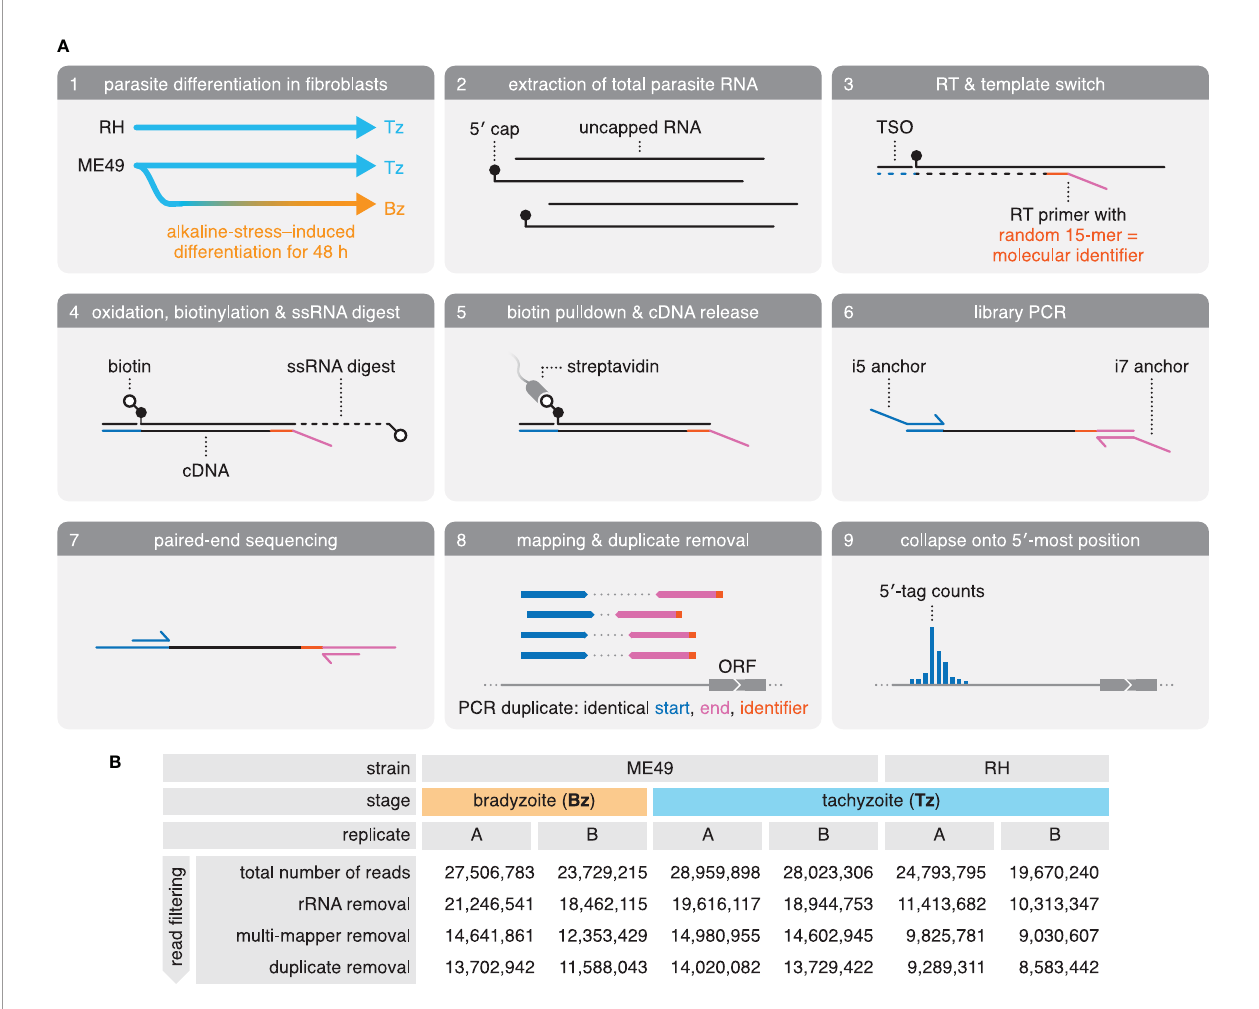
FIGURE 1 | Generation and sequencing of 5 ′ -intact cDNA libraries from total RNA extracts of multiple Toxoplasma strains and life-cycle stages. (A) Preparation and sequencing of 5 ′ -intact cDNA (RAMPAGE) libraries. Total RNA was extracted from RH and ME49 Tz, as well as ME49 Bz that were differentiated by culture in alkaline-pH medium. Sequencing adapters were introduced during reverse transcription (RT). Here, an RT primer anneals randomly to RNA transcripts, introducing the Read 2 sequencing adapter (magenta), and a template-switching oligo (TSO) introduces the Read 1 sequencing adapter (blue) at the 5 ′ end of the RNA transcript. 5 ′ -intact cDNA was enriched via a cap-trapping strategy, in which riboses with free 2 ′ - and 3 ′ -hydroxyl groups are oxidized and biotinylated, and single- stranded portions of RNA (ssRNA) are digested by RNase I. This retains biotin only at the cap-structure of 5 ′ -intact RNA transcripts, which was used in a streptavidin pulldown to enrich for the 5 ′ -intact cDNA within the RNA-cDNA heteroduplex. Libraries were ampli fi ed by PCR, introducing the i5 and i7 anchor sequences for Illumina fl ow cells. Following size selection, libraries were paired-end sequenced. Reads were mapped onto the ME49 genome assembly. Duplicate reads were identi fi ed by their identical alignment positions; however, over-collapsing was prevented by exploiting the fact that the RT primer often primes with mismatches, providing a pseudo-random molecular identi fi er. Deduplicated and fi ltered reads were then collapsed onto the fi rst nucleotide of Read 1 to generate 5 ′ -tag counts across the genome. ORF, open reading frame. (B) Summary of sequencing of RAMPAGE libraries and read fi ltering. rRNA, ribosomal